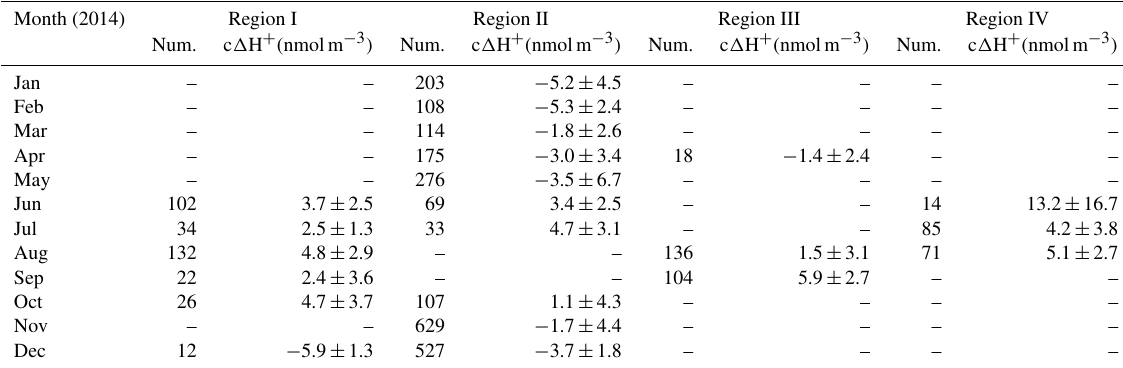
Table 2. Number counts of trajectories used in Fig. 7 and corresponding monthly averaged acidities of particles (c (cid:49) H + ) in coarse mode for different regions. Hyphens indicate the months when the number counts of trajectories are <